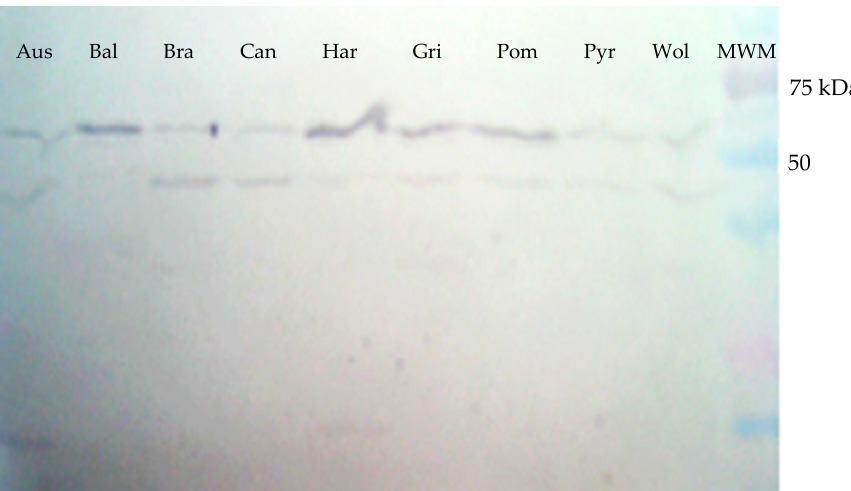
Figure 3. Western blot of the total protein extracts obtained from cultures of nine Leptospira serovars. An approximately 63 kDa band was shown when a rabbit antiserum against rGspDLC was used